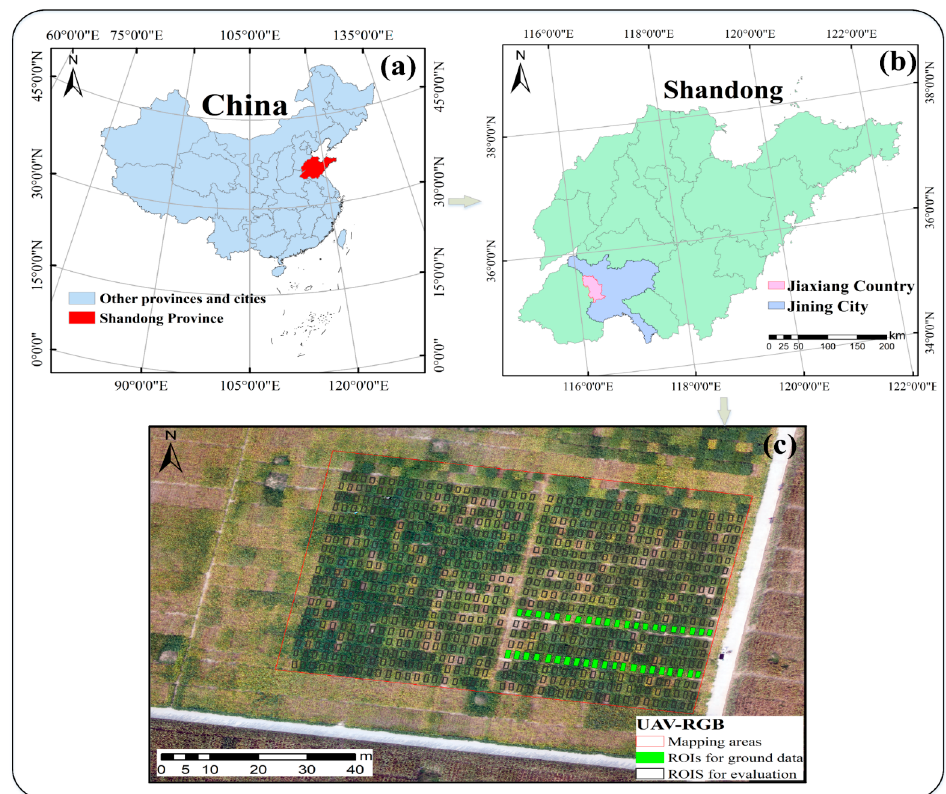
Figure 1. Study area and experimental sites: ( a ) location of the study area in China; ( b ) map of Jiaxiang County, Jining City, Shandong Province; ( c ) UAV RGB images and actual data collection sites. Note: The green ROI in ( c ) is the ground data collection area, and the 800 black boxes ROIs are used for monitoring and evaluation (including the area where the ground data collection ROIs are located).